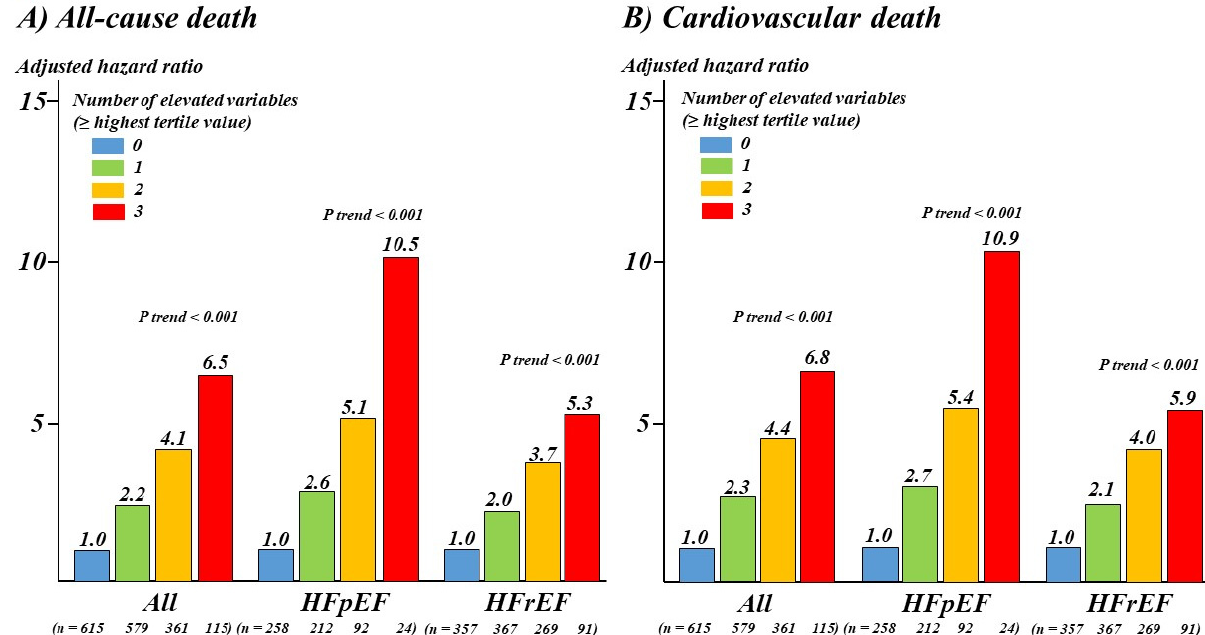
Figure 3. Adjusted hazard ratios of the number of elevations ( ≥ the highest tertile value) in D-dimer levels ( ≥ 2.6 µ g/mL), GWTG-HF risk score ( ≥ 43 points), and NT-proBNP ( ≥ 7432 pg/mL) for all-cause ( A ) and cardiovascular death ( B ) in all populations, HFpEF patients, and HFrEF patients. Multivariable models were adjusted for all baseline variables with p < 0.05 in univariate analyses. HFpEF—heart failure with preserved ejection fraction; HFrEF—heart failure with reduced ejection fraction.